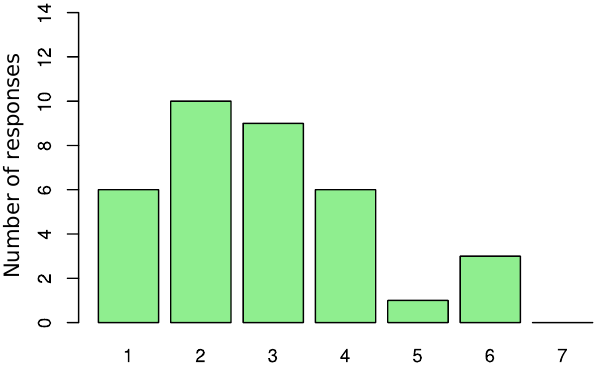
Figure 6. Evaluation of disturbance of the wrist watch in daily